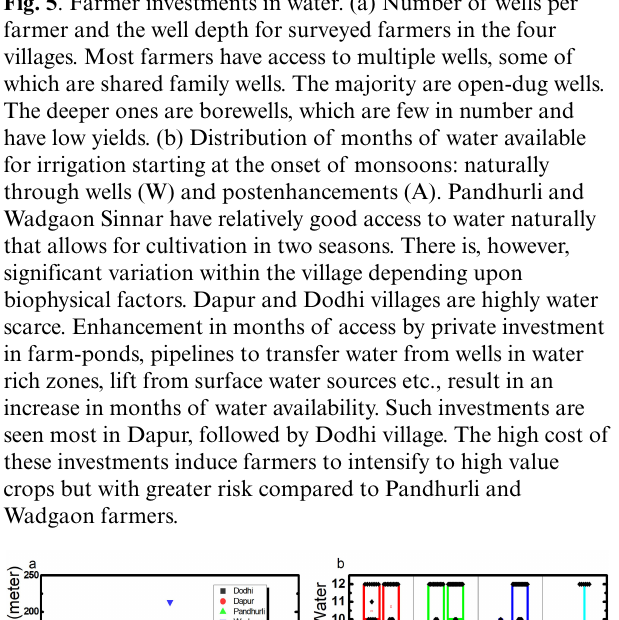
Fig. 5 . Farmer investments in water. (a) Number of wells per farmer and the well depth for surveyed farmers in the four villages. Most farmers have access to multiple wells, some of which are shared family wells. The majority are open-dug